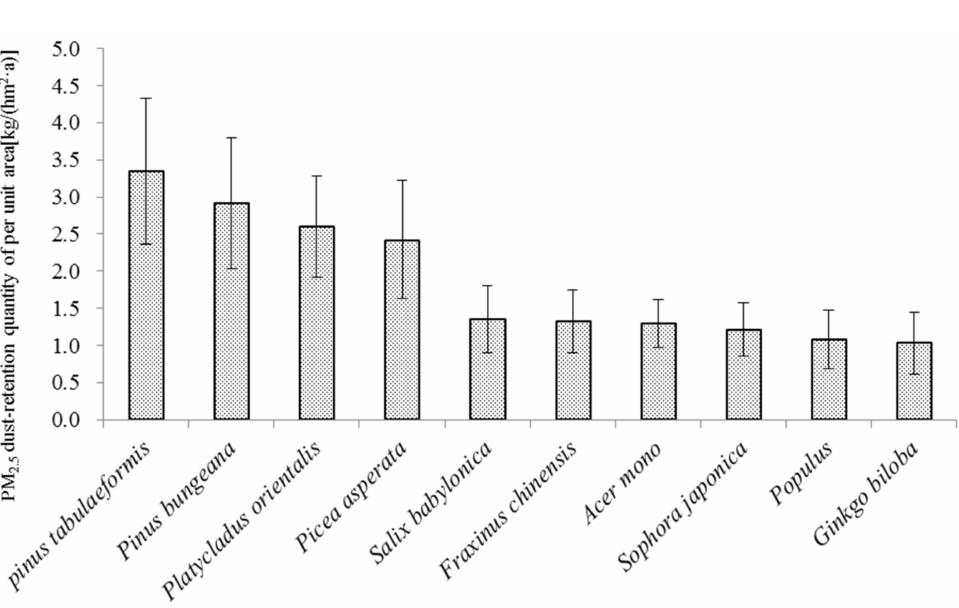
Figure 2. Annual PM 2.5 dust-retention capacity per hectare of different tree